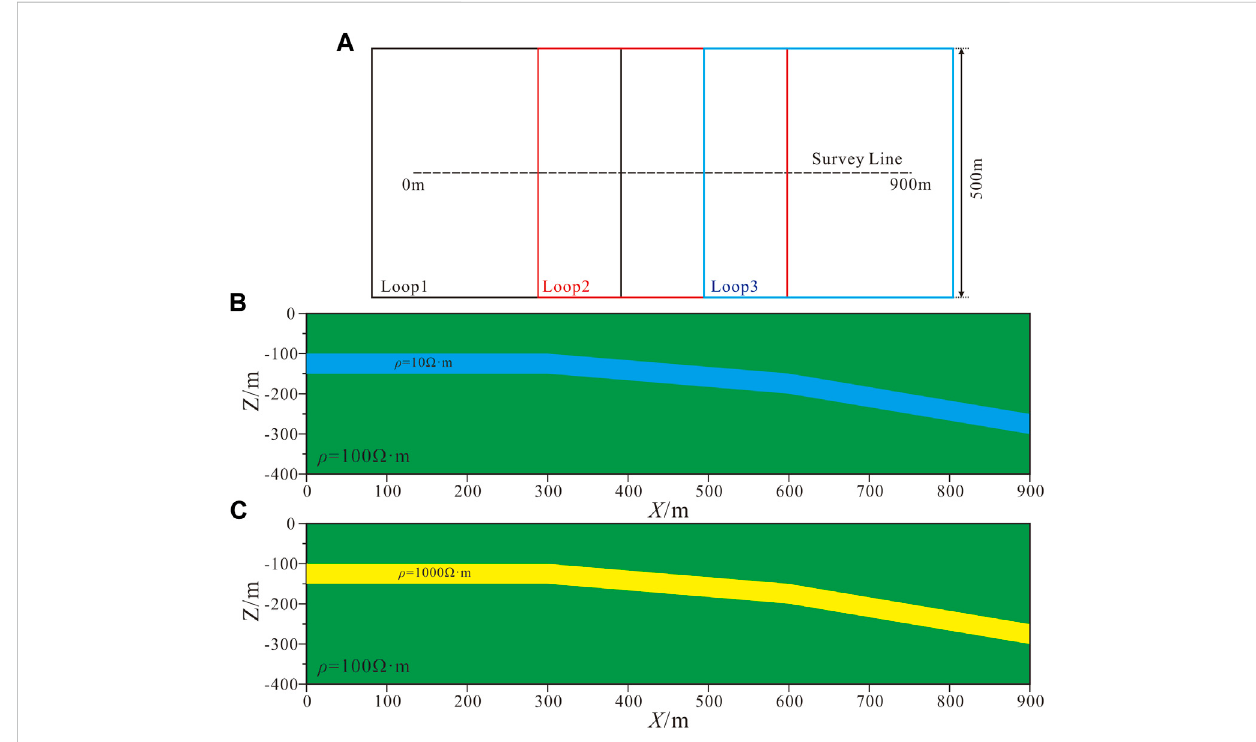
FIGURE 1 Synthetic model of inclined strata (A) : Receiving and transmitting schematic. (B) : H-type model. (C) : K-type